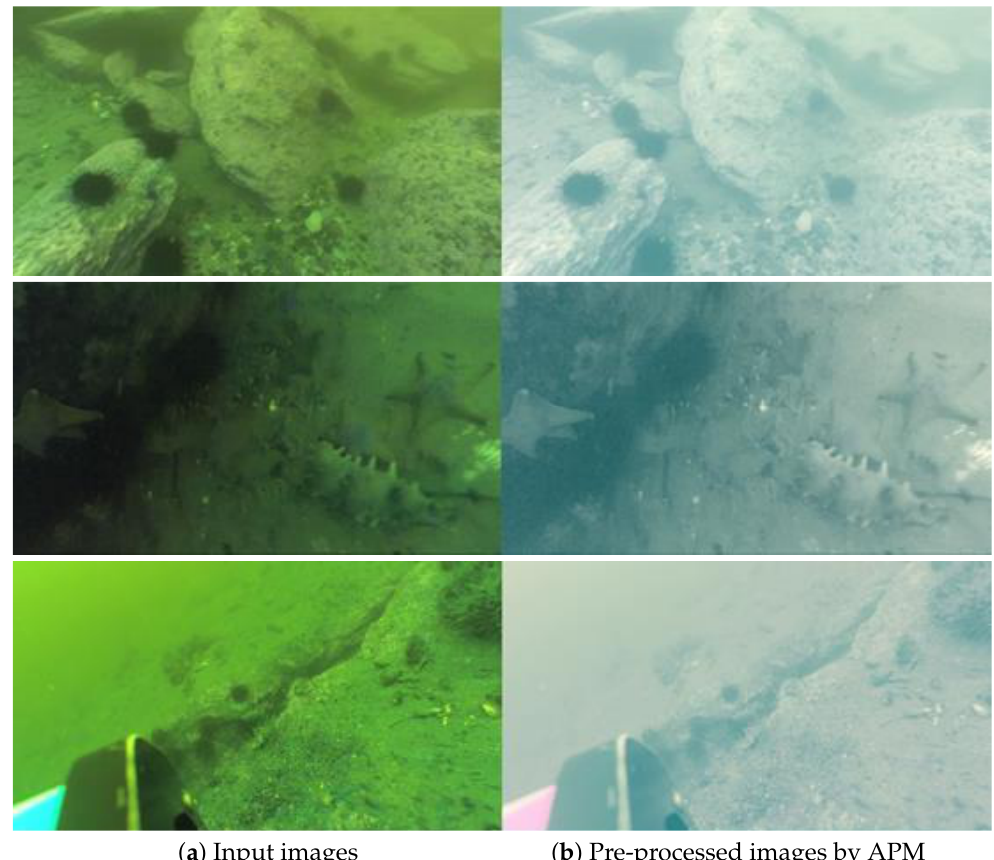
Figure 9. Compared to the original images ( a ), the pre-processed images output by APM ( b ) correct the underwater color bias to an